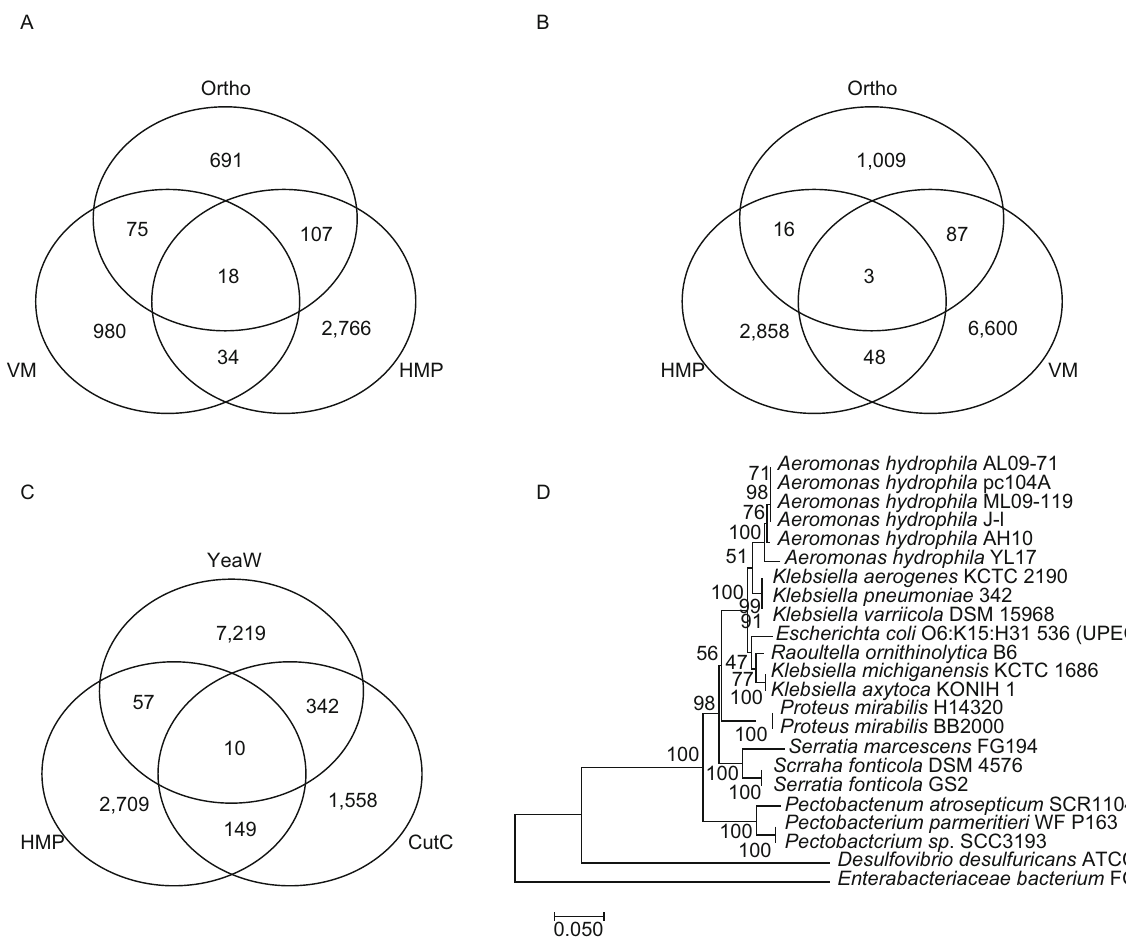
Figure 2. Predicted bacteria strains encoding the cutC/yeaW/cntA TMA lyases. (A) Predicted bacteria strains encoding cutC gene. Abbreviation, HMP, the NIH Human Microbiome Project (Data release 1.1, September 26, 2017 e), Ortho, cutC encoding gene of OrthoDB (http://www.orthodb.org/v9.1/) (Zdobnov et al., 2017), and VM, data from the reference (Rath et al., 2017). (B) Predicted bacteria stains encoding yeaW/cntA genes. Ortho, yeaW encoding gene of OrthoDB. (C) Predicted bacterial strains encoding both yeaW and cutC. (D) Phylogenetic gene tree of cutC encoding strains. The Neighbor-Joining tree was built with MEGA7 (Kumar et al.,